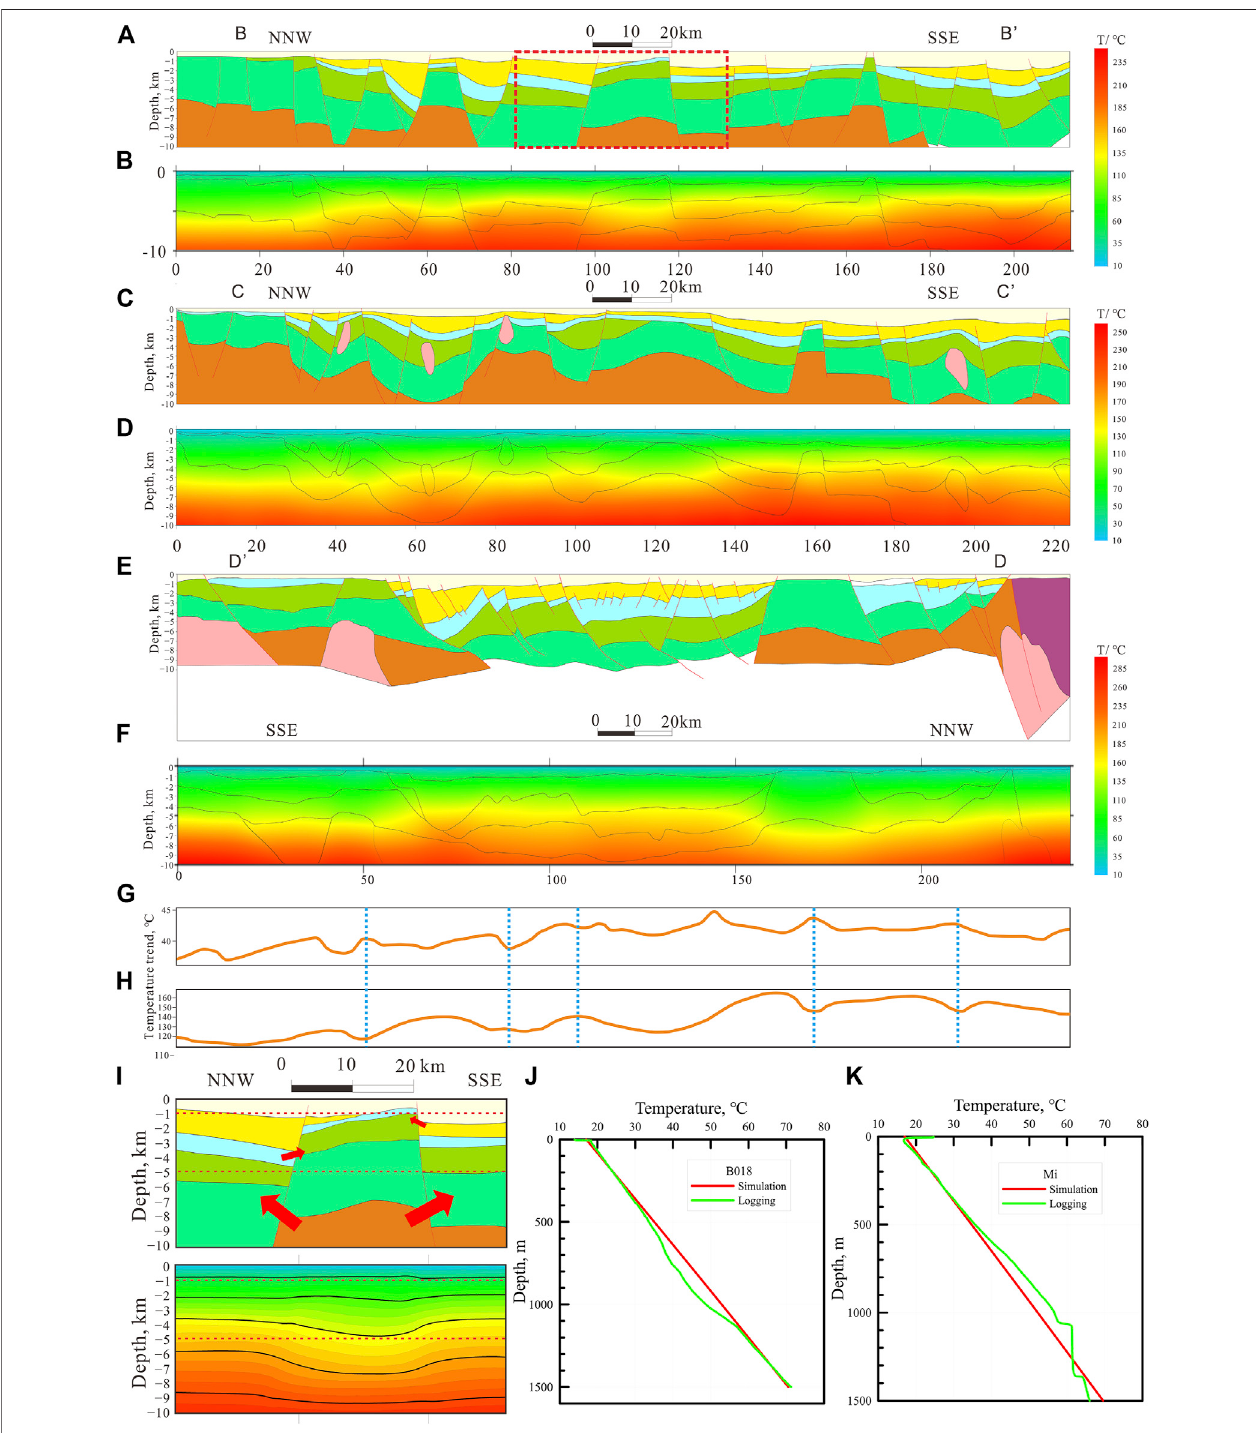
FIGURE8|(A – E) ,two-dimensionaltemperature fi eldsimulationofsectionsB-B,C-C,andD-D ′ in Figure1C . (G,H) representsthetemperaturevariationofpro fi le C-C ′ in Figure 1 at 0.5 and 4.5 km depth, respectively. Plot (I) is a zoomed-in view of the stratigraphic and simulation results in Figure a (red dashed box). (J,K) are comparisons of simulated and measured values of depth-temperature curves in 2 boreholes.